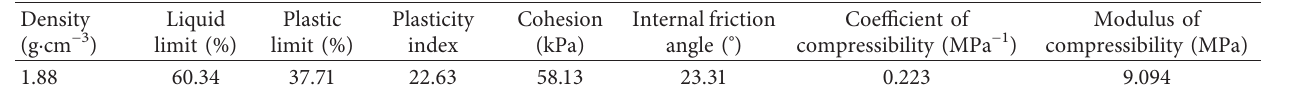
Figure 1: Location of Yuzhou city. Table 1: Physical and mechanical properties of clay soil.